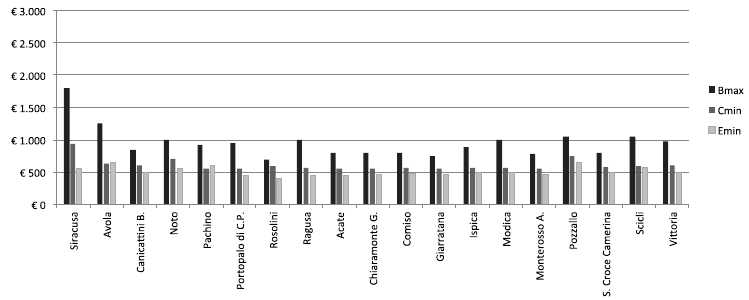
Figure 7. Purchase. Housing prices in euros/m 2 ( y -axis) in the municipalities of the SES area (II semester 2016) (our elaboration on Real Estate Market (OMI) data).